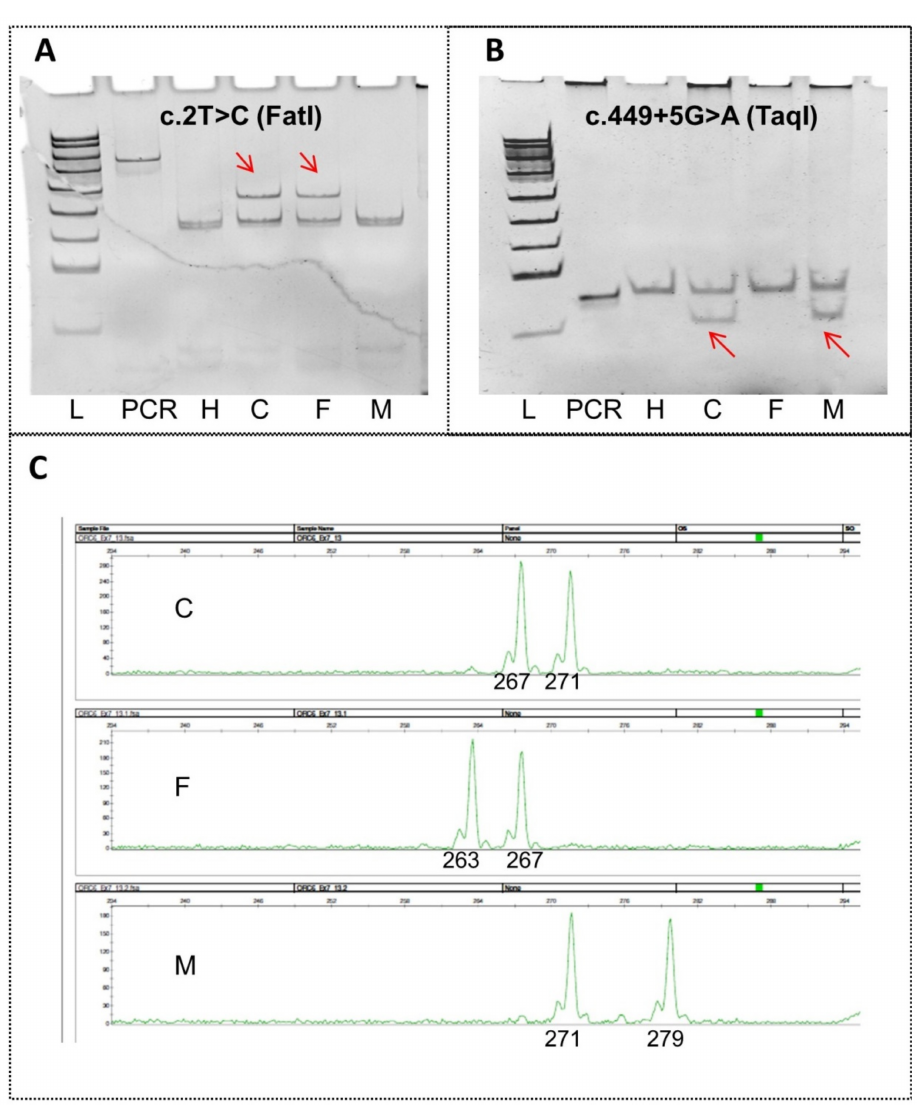
Figure 3. The prenatal genetic diagnostic system for c.2T>C(p.Met1Thr) and c.449+5G>A of the ORC6 gene. ( A , B ) PCR-RFLP and PAGE analyses; ( C ) PCR and fragment analysis of AGAT repeats of exon 7. Lane L: pUC19/MspI Ladder; lane ‘PCR’: the undigested amplicon; lane H: an unrelated healthy control; lane C: the affected child; lane F: father; and lane M: